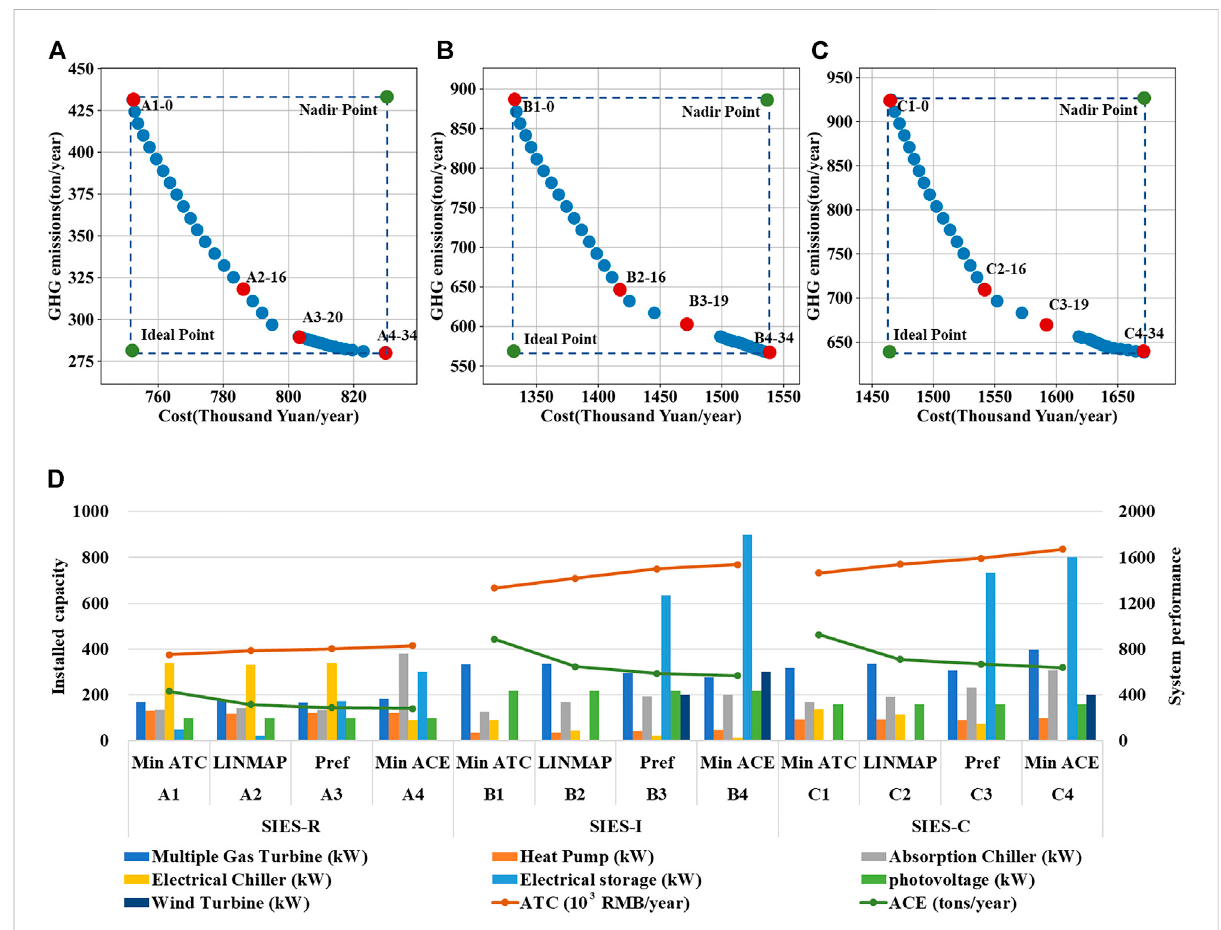
FIGURE 7 The results of the planning optimization of subsystems. Pareto frontiers of subsystem planning in residential, industrial, and commercial areas are shown in (A – C) . Figure (D) shows the installed capacity, annual total cost, and annual carbon emission for typical planning.